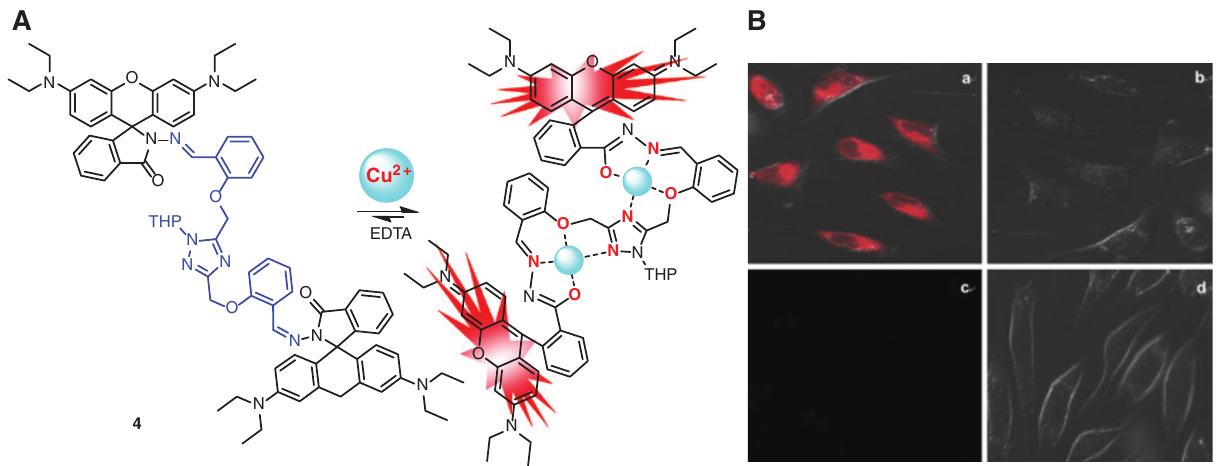
Figure 6: (A) Recognition mechanism of probe 4 with Cu 2 + and (B) confocal fluorescence images in MCF-7 cells. Reprinted from Zhang et al. (2012).